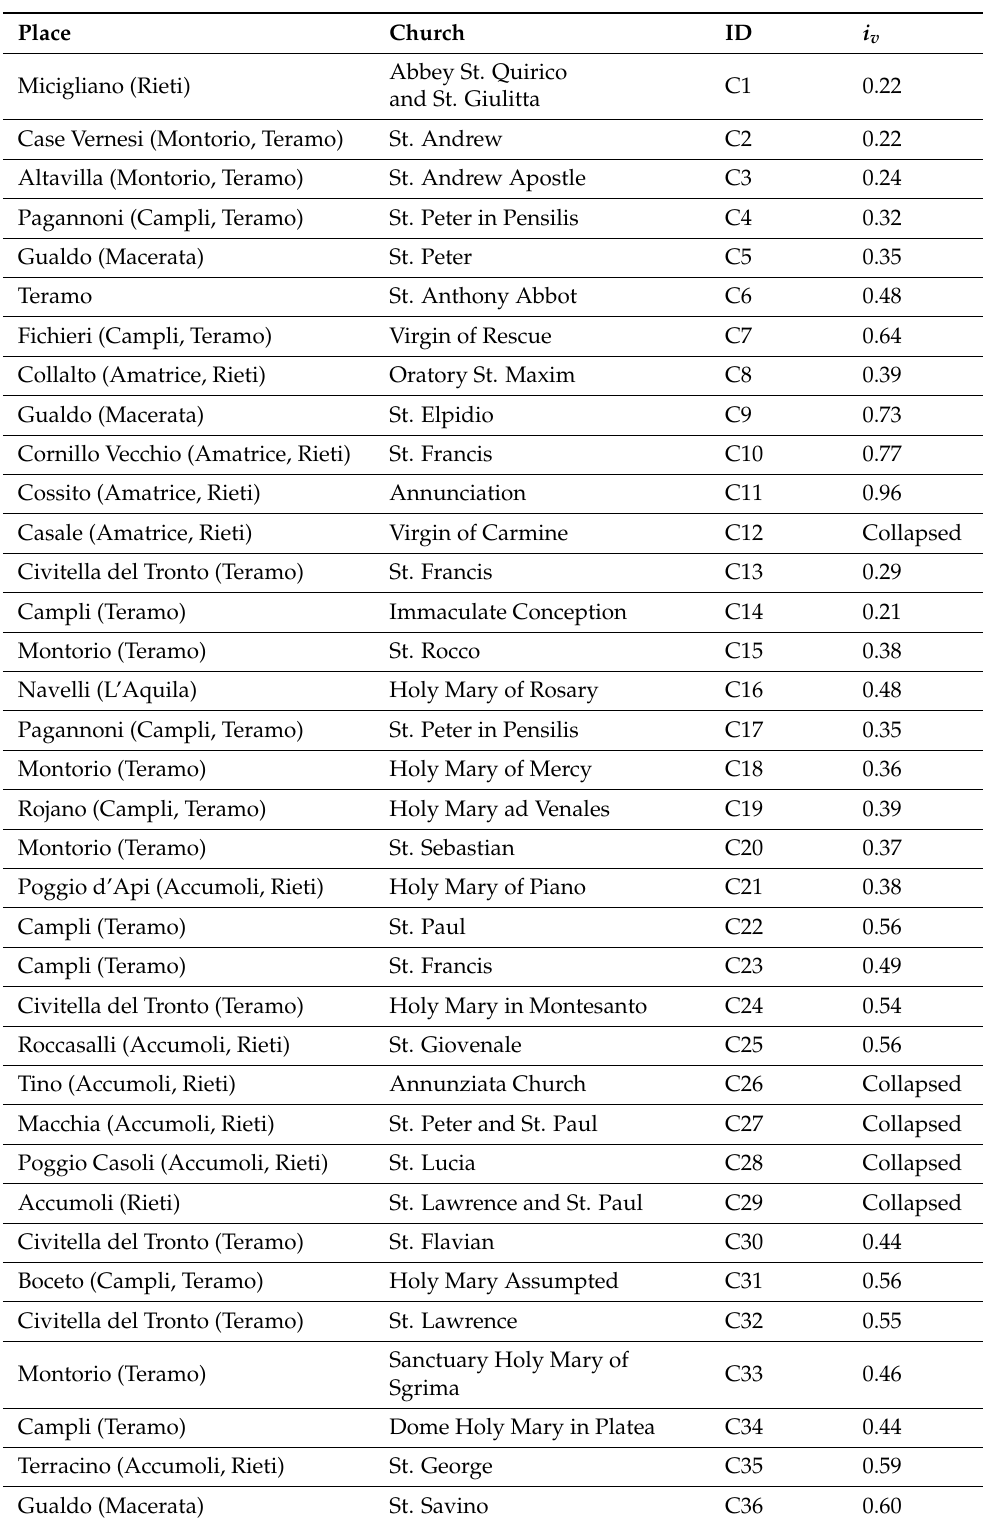
Table 2. Inspected churches list: Location, name, identification number (ID), and vulnerability index ( i v ) evaluated according to the LV1